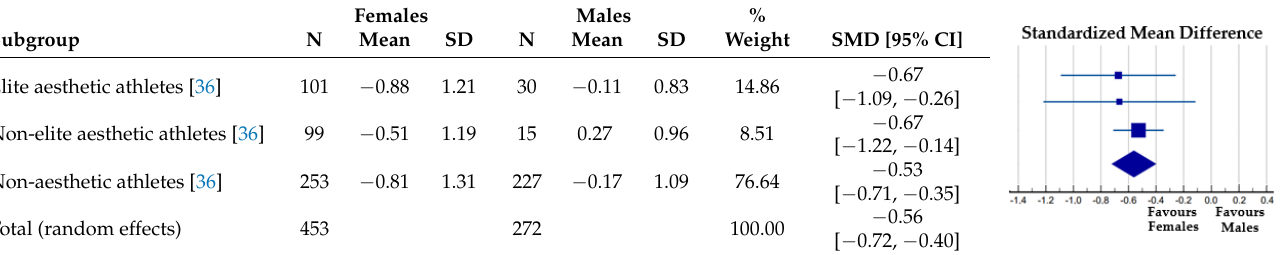
Table 3. BID by type of sports in female